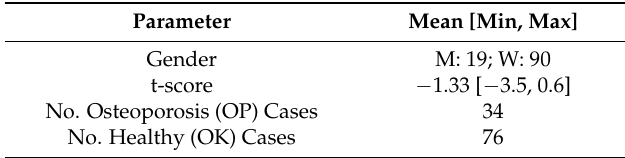
Table 1. Population Statistics.